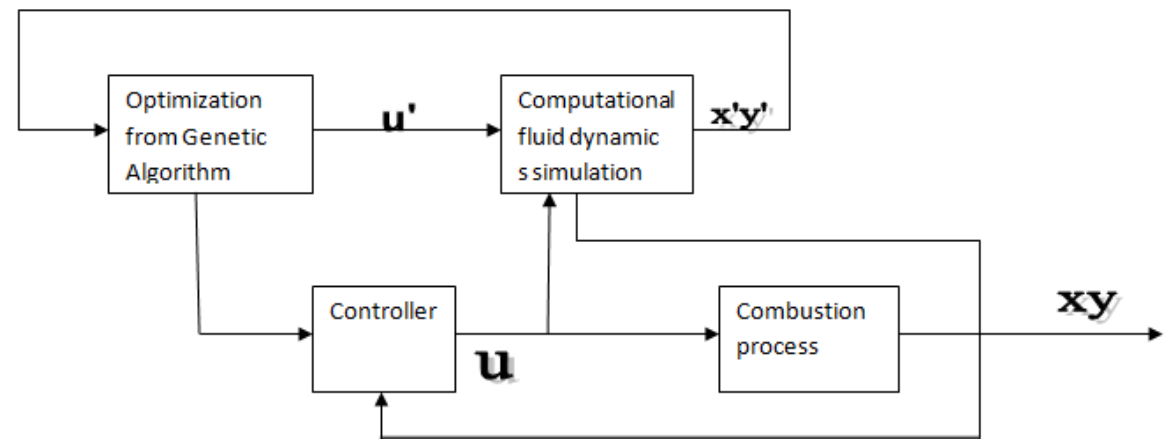
Figure 23. Integrated diagram of GA with CFD for combustion optimization.